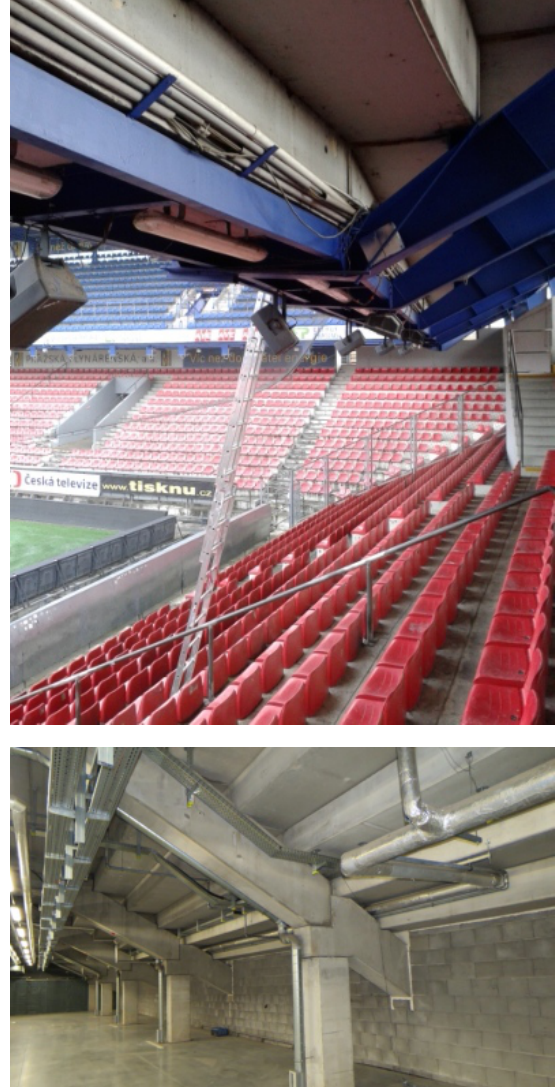
Figure 3. Construction of monitored grandstands: Football stadium – Prague Letna(upper) [2], Football stadium – Prague Eden (lower)